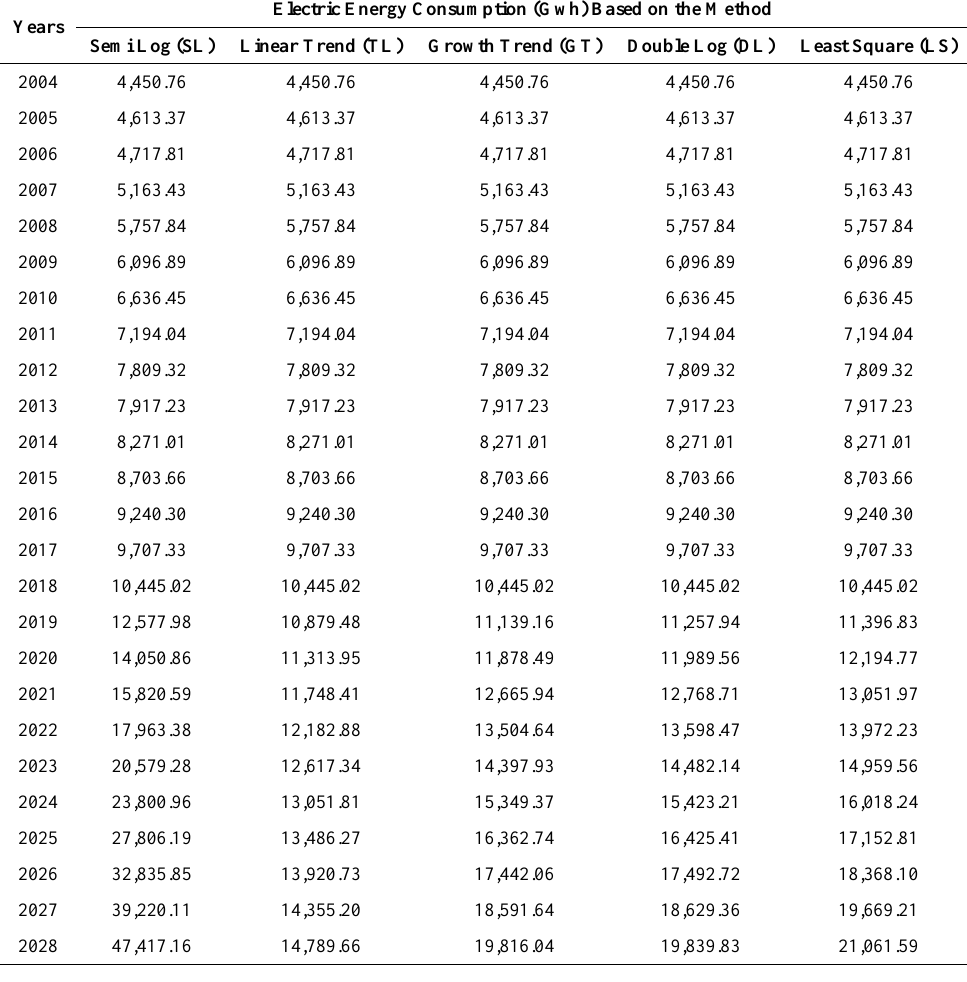
Table 7. Test results using Simple